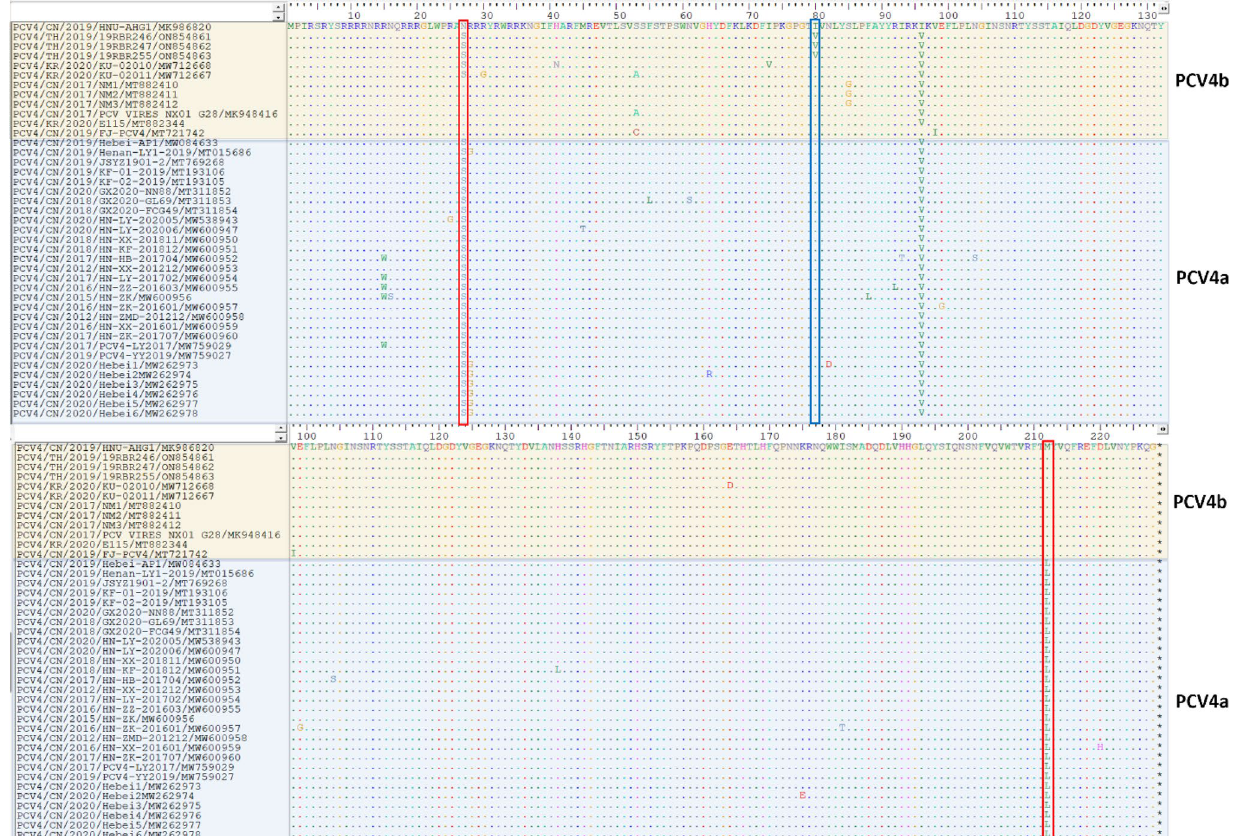
Figure 3. Comparison of Cap amino acid sequences of PCV4 isolates in this study. Dots are used to denote the residues that are consistent with HNU-AHG1 (MK986820). The red boxes indicate the amino acid at positions 27 and 212, previously proposed for differentiation of PCV4a and PCV4b. Mutations at residues position 80 of Thai PCV4 strains are shown with the green